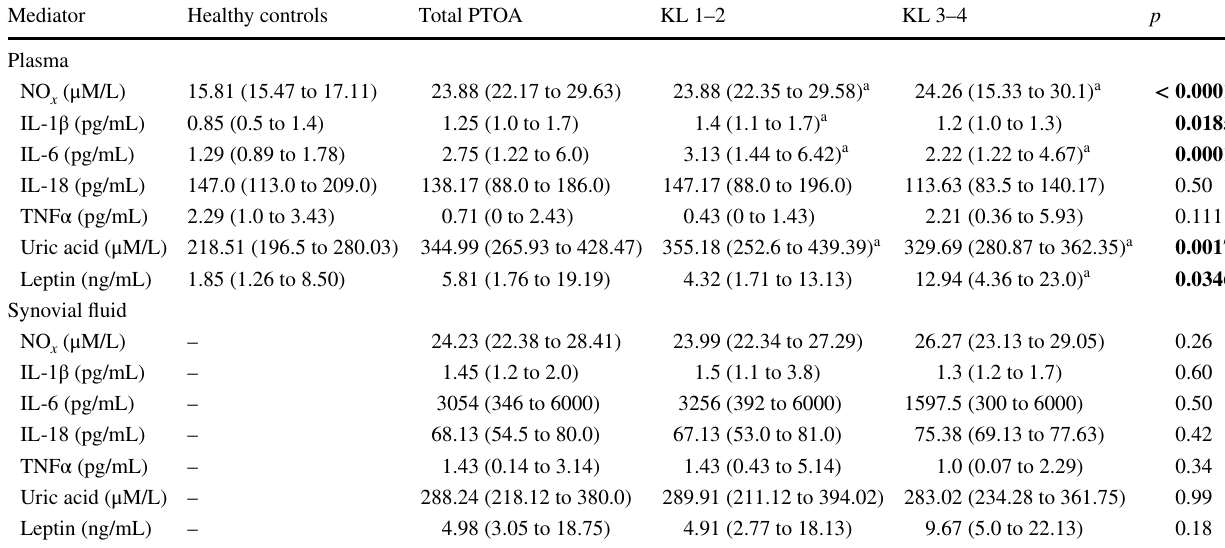
Data are presented as median (25 to 75% quartiles). The plasma levels of mediators were compared by performing a Kruskal–Wallis test of three groups—the healthy, KL 1–2, and KL 3–4 subgroups—and a subsequent Dunn’s test. The SF levels of mediators were compared by